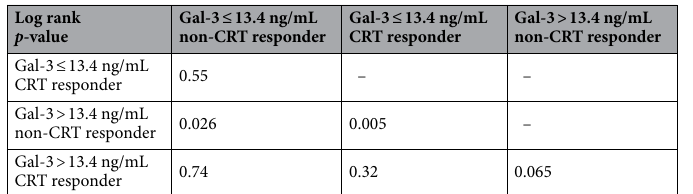
Table 3. Pairwise comparisons using the log-rank test with Bonferroni adjustment performed between groups defined by baseline Gal-3 concentration and CRT response.